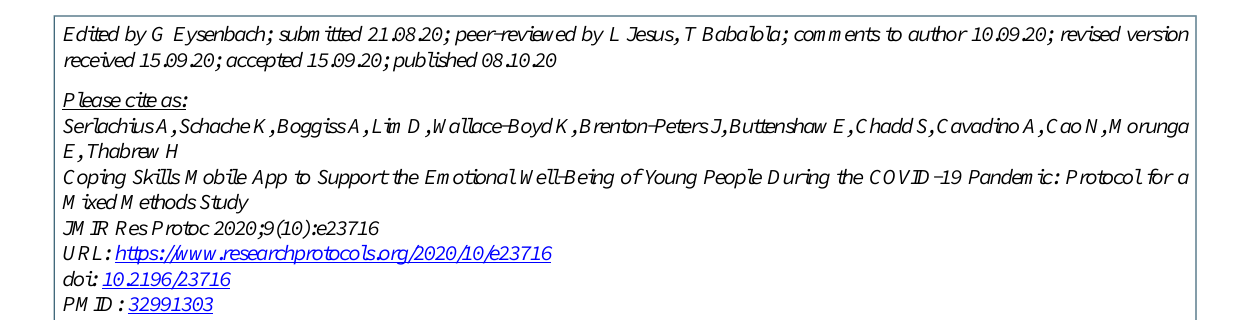
Coping Skills Mobile App to Support the Emotional Well-Being of Young People During the COVID-19 Pandemic: Protocol for a Mixed Methods